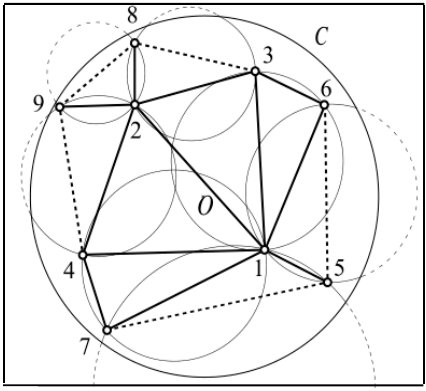
Figure 1. Incremental sweep circle algorithm used to construct Delaunay triangulation.